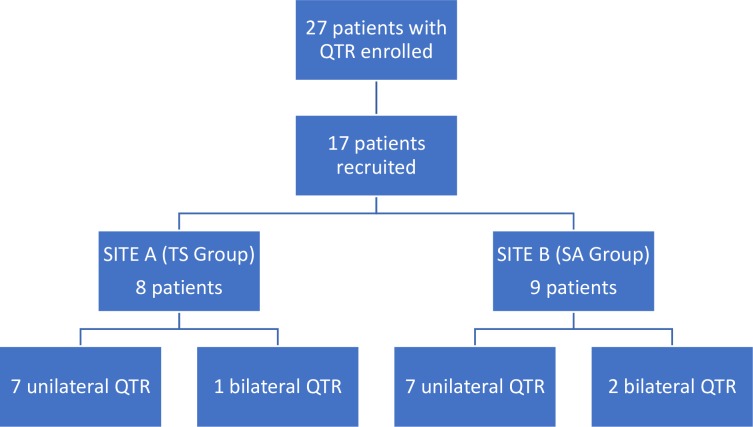
Recruitment protocol.SA: suture anchor, TS: transosseous suture, QTR: quadriceps tendon rupture.